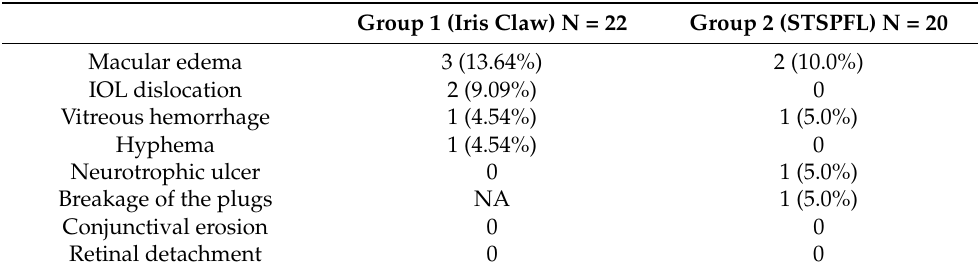
Table 3. Summary of postoperative